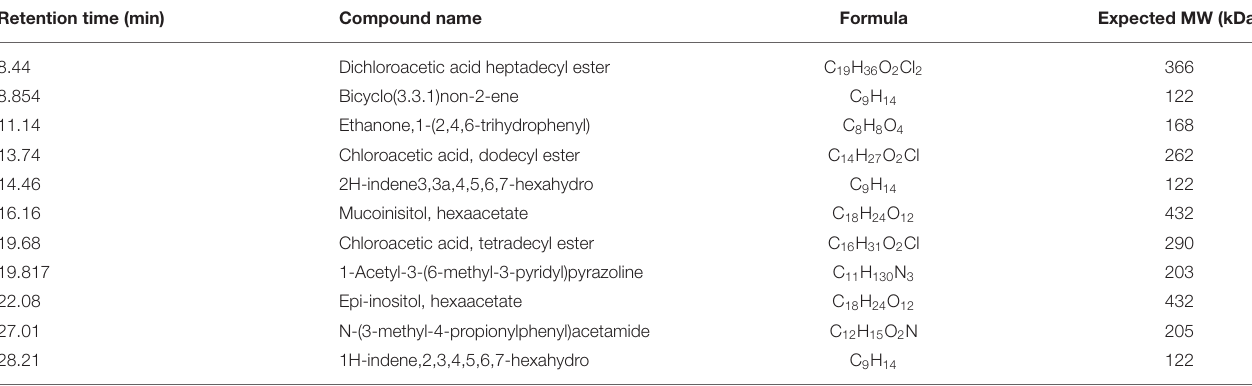
TABLE 4 | GC-MS analysis of sugar derivatives produced during the course of Haria fermentation. Retention time